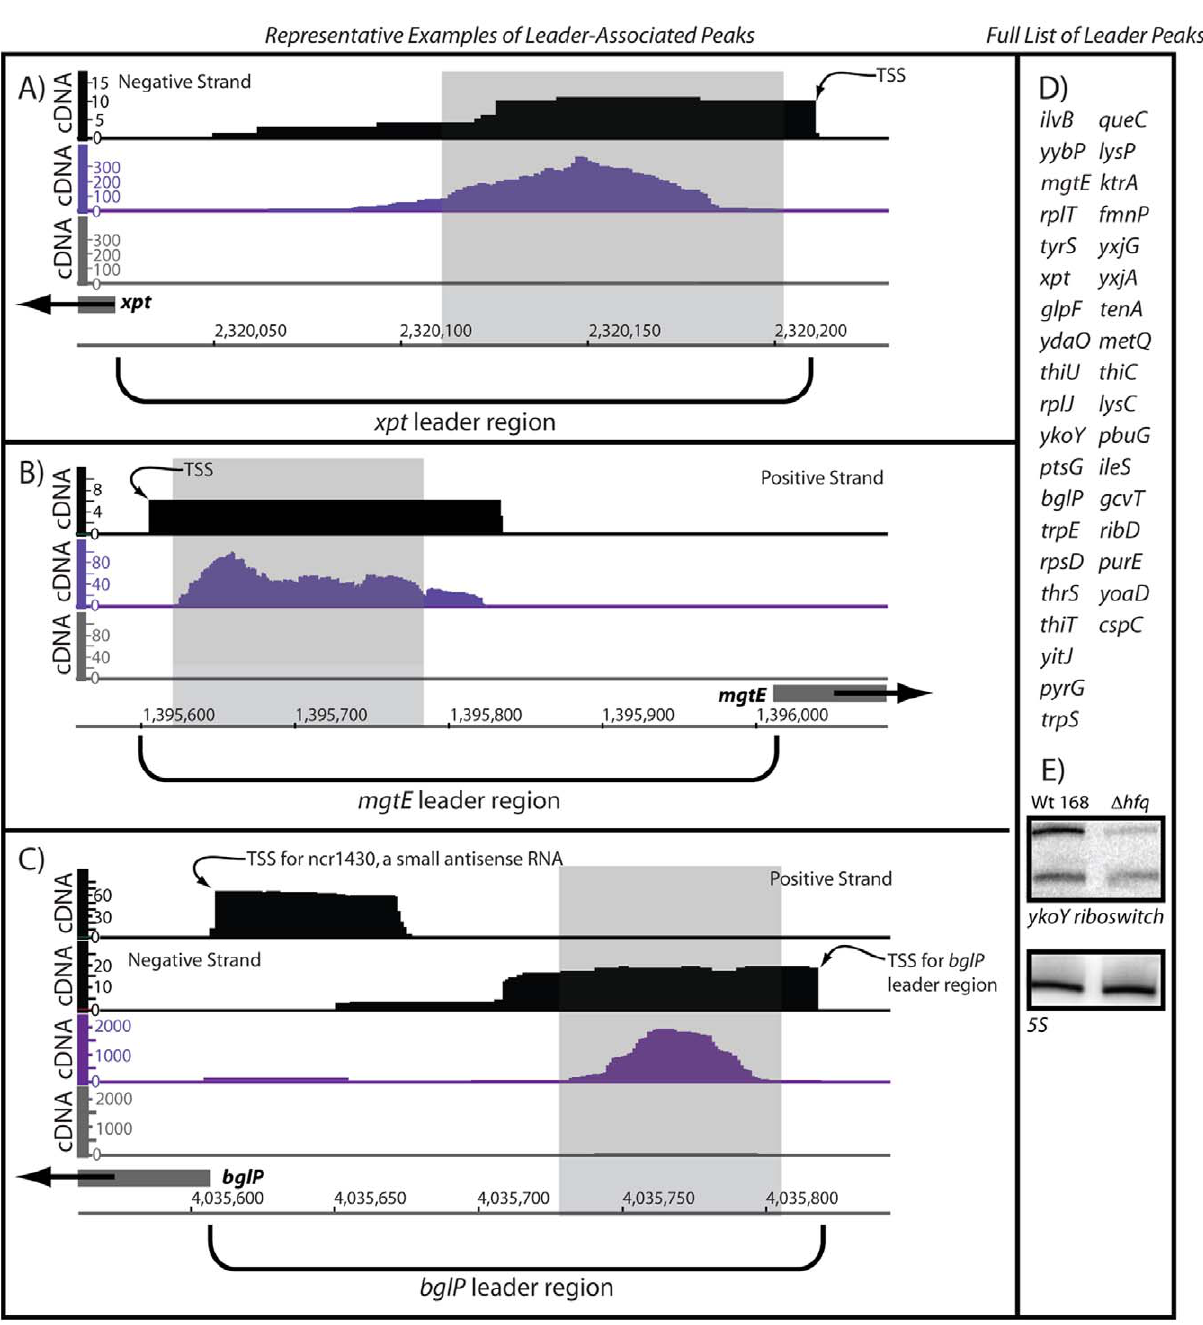
Figure 4. Hfq enrichment of signal-responsive, cis -acting regulatory RNAs. (A) An individual representative example is shown for Hfq- mediated enrichment of the leader region of a purine-sensing riboswitch [68]. The ligand-binding aptamer region is denoted by a shaded box to indicate the overlap between this sensory domain and the RNA sequences found to associate with Hfq. Previously measured transcription start site (TSS) mapping data (shown in black; [33]) is also shown in the figure as a means of denoting the 5 9 end of the leader region. (B) An example is shown for Hfq-mediated enrichment of the leader region of a magnesium-sensing riboswitch [69]. The magnesium-sensing domain [70] is denoted by a shaded box. (C) Representative data are shown for Hfq-mediated enrichment of the leader region of a protein-responsive cis-acting regulatory RNA. Specifically, the bglP operon has been previously postulated to be subjected to multiple layers of regulatory control, including by transcription initiation factors, a protein-responsive leader region, and a small, putative antisense RNA that appears to base pair with the ribosome binding site. Although the latter antisense RNA was modestly enriched by coIP with Hfq, the protein-binding aptamer region was highly enriched by Hfq in this study (shown in purple). (D) Other leader regions that associated with Hfq are listed herein. More details on these RNAs are included in Table S3. Throughout the figure, the y-axis shows the volume of cDNA reads as a function of genomic position (x-axis) as determined by Illumina-based sequencing of Hfq-associated RNA molecules. Data shown in gray correspond to the negative control reaction (coimmunoprecipitation of Hfq that lacked an epitope tag). Data shown in black correspond to a prior transcription start site (TSS) mapping study and are included in this figure as a means of denoting the 5 9 ends [33].